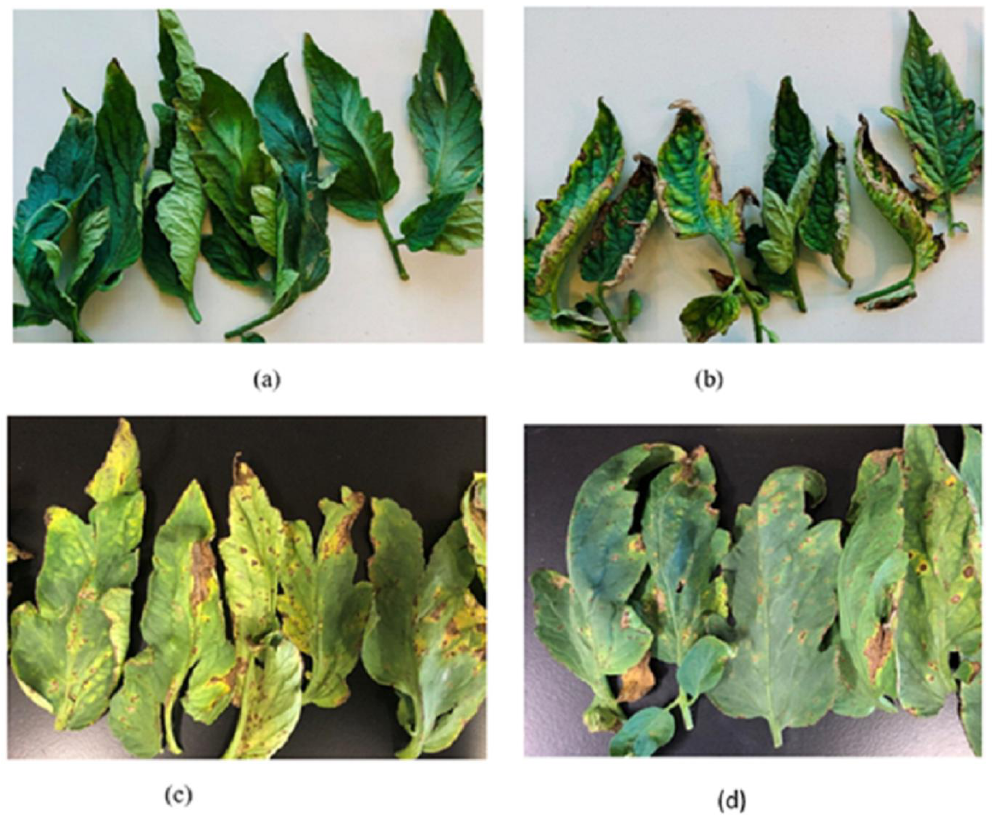
Figure 1. Tomato leaves collected to measure their spectral reflectance—tomato yellow leaf curl (TYLC)-infected leaves: ( a ) tolerant variety, ( b ) susceptible variety, and leaves infected by ( c ) target spot and ( d ) bacterial spot.